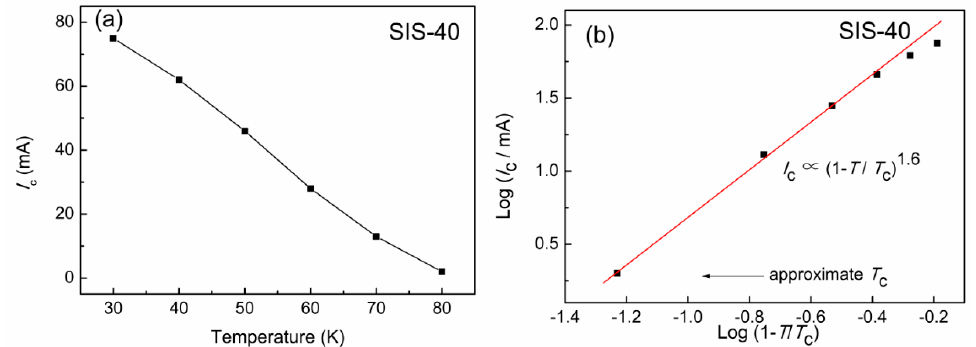
Figure 8. Curves showing the variation of I c for the YBCO/LAO (40 nm)/YBCO trilayer with the test temperature: ( a ) I c vs. T , ( b ) log I c vs log (1 − T / T c